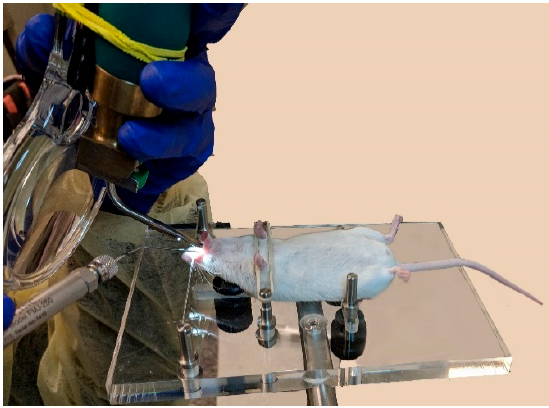
Figure 2. Mouse intubation using the MicroSprayer ® Aerosolizer (Penn-Century, Wyndmoor, PA, USA). The microsprayer is inserted into the trachea of the mouse with the help of a small animal laryngoscope.